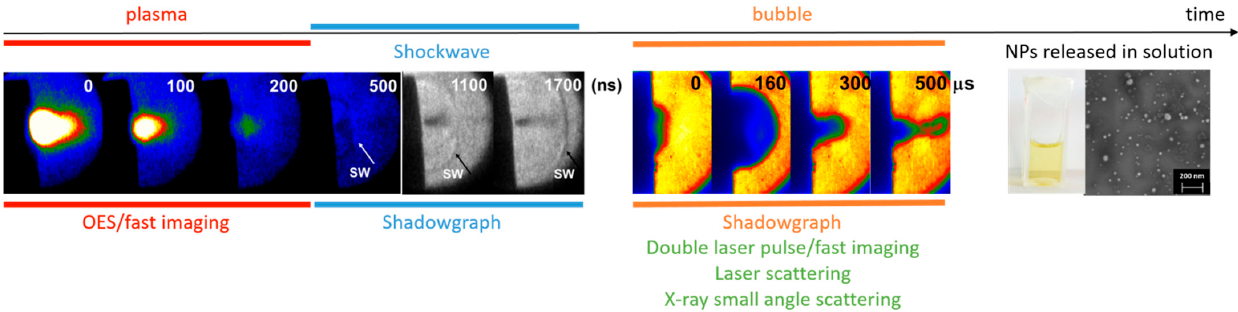
Figure 1. Temporal sequence of PLAL processes with the employed diagnostic techniques. All the images in the sketch have been recorded in the VIS spectral range (400–650 nm).